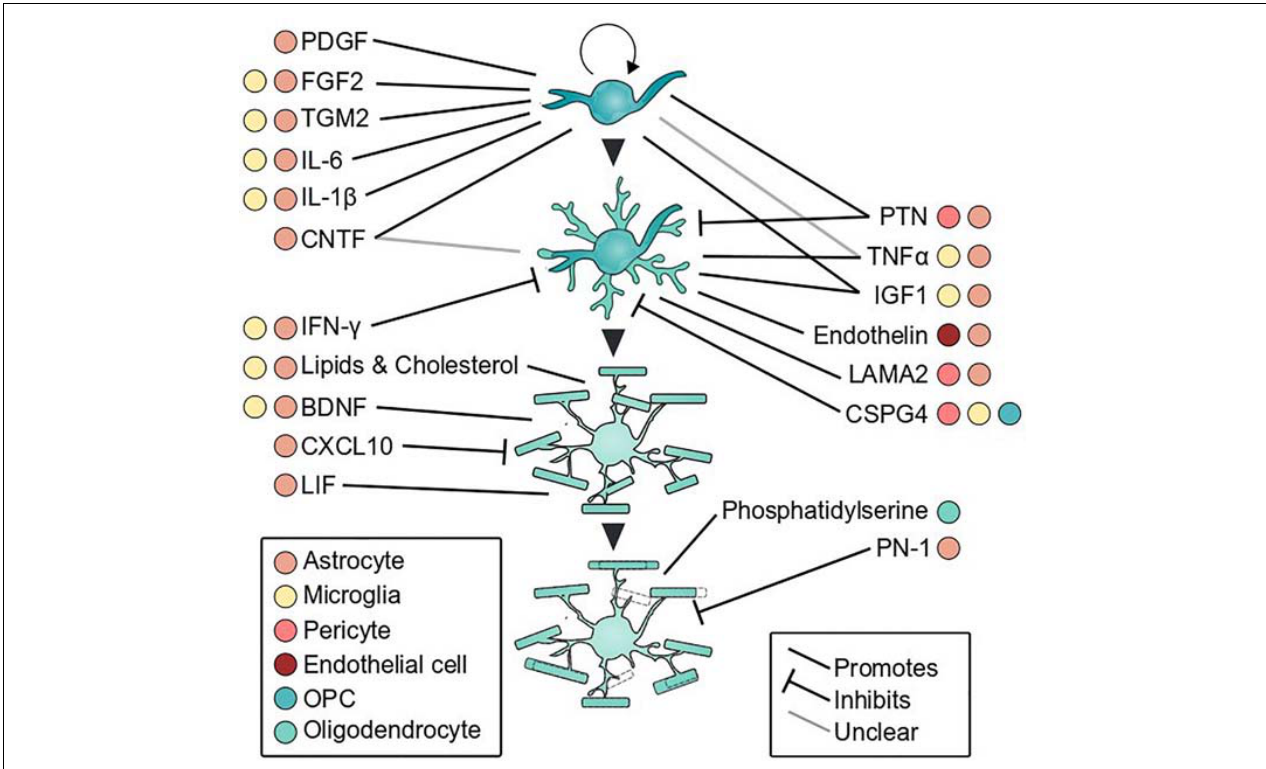
FIGURE 3 | Glial secreted factors that influence oligodendrocyte development. Oligodendrocyte proliferation, differentiation, myelination, and myelin remodeling are shaped by cues secreted by glial cells. Colored dots indicate cell types that secrete each factor and line type denotes direction of effect. References for each factor are listed in Table 1